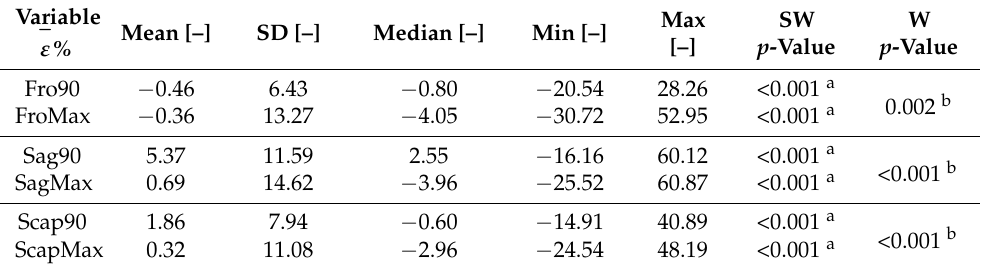
Fro90: 90 ◦ elevation in the Frontal plane; FroMax: maximum elevation in the Frontal plane; Sag90: 90 ◦ elevation in the Sagittal plane; SagMax: maximum elevation in the Sagittal plane; Scap90: 90 ◦ elevation in the Scapular plane; ScapMax: maximum elevation in the Scapular plane; SD: Standard Deviation; Min: minimum; Max: Maximum; SW: Shapiro-Wilk test; W: Wilcoxon rank-sum test. a Indicates no normal distribution; b Indicates statistical